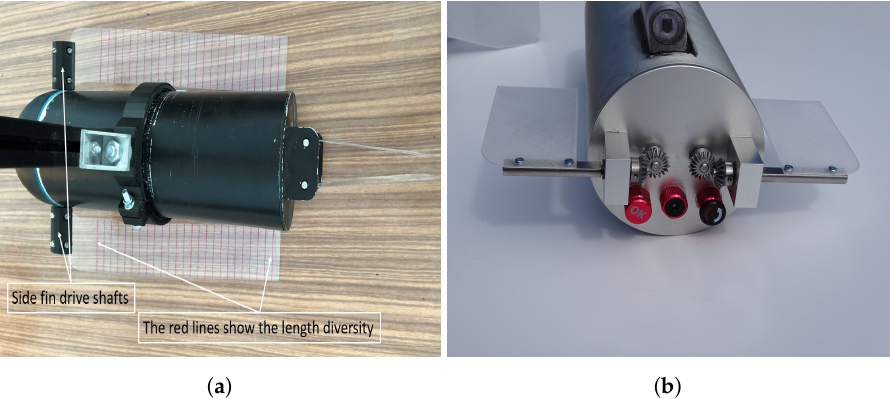
Figure 3. Top view of the BUUV with side fins ( a ) and front view of (without bow dome) the propeller shaft with bevel gear ( b